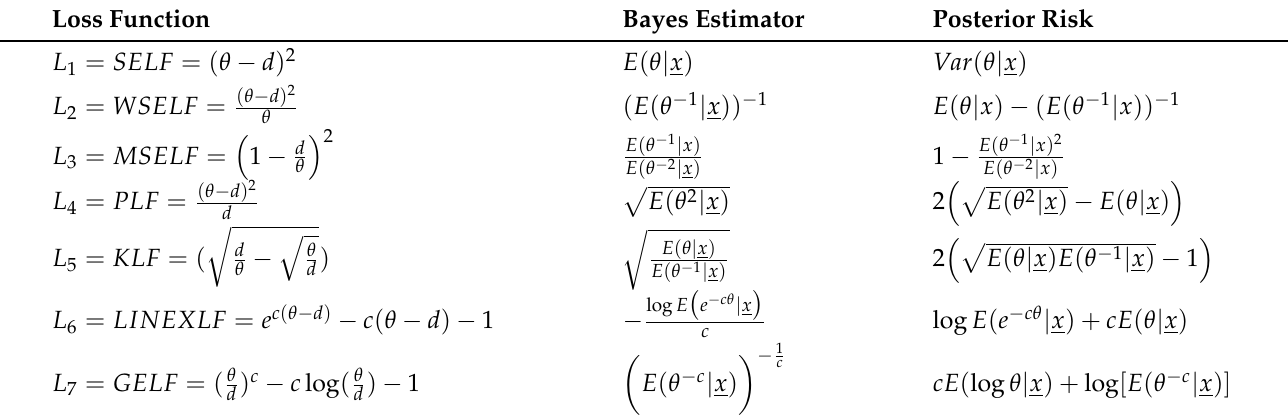
Table 1. Seven loss functions with Bayes estimator and related posterior